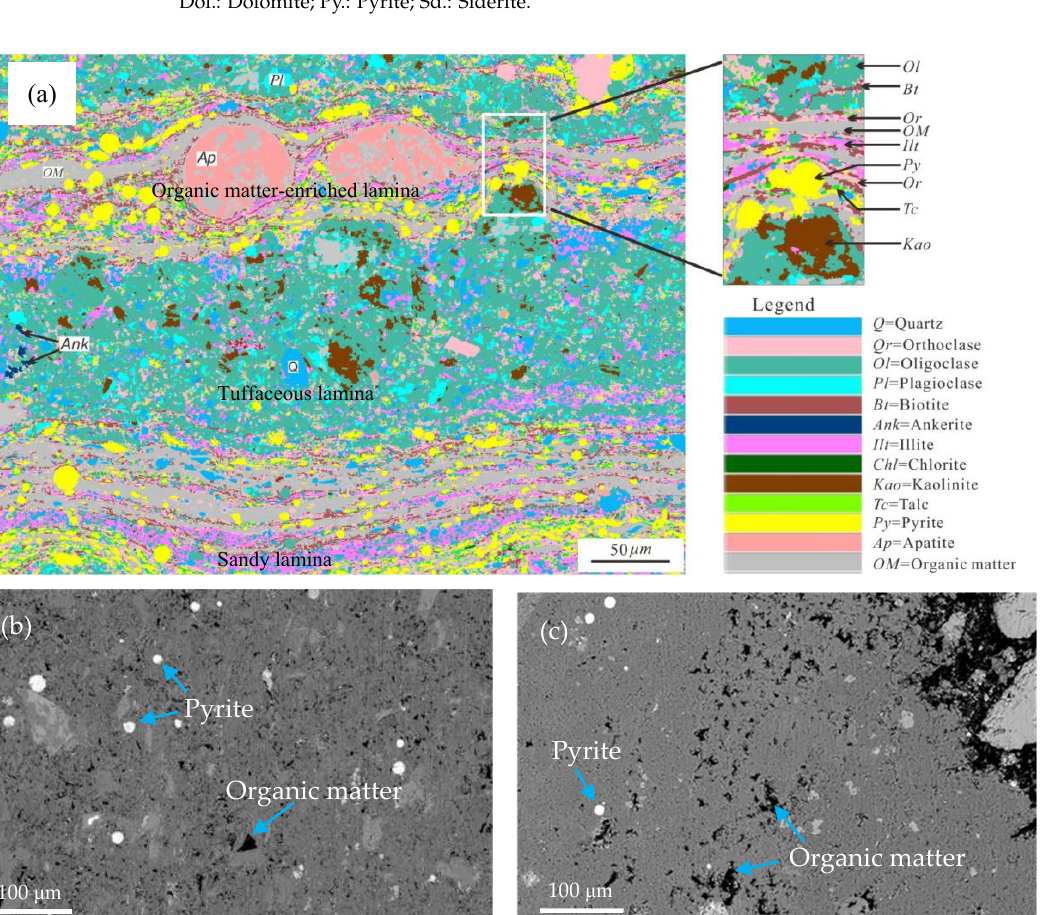
Table 1. Mineralogical composition analysis of the Chang 7 shale [20].